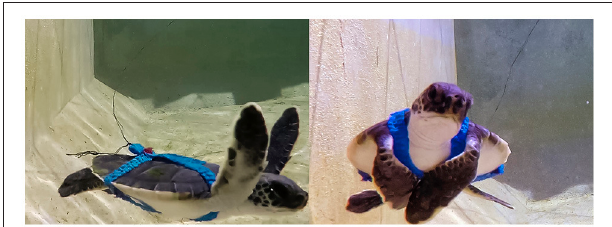
FIGURE 2 | Images of the harness design and application on Chelonia mydas hatchlings. Footage from an underwater GoPro camera.